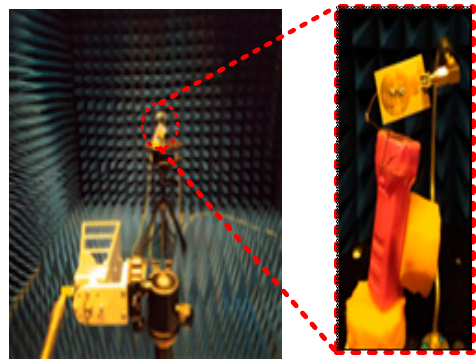
Figure 10. Far-field radiation pattern measurement setup.